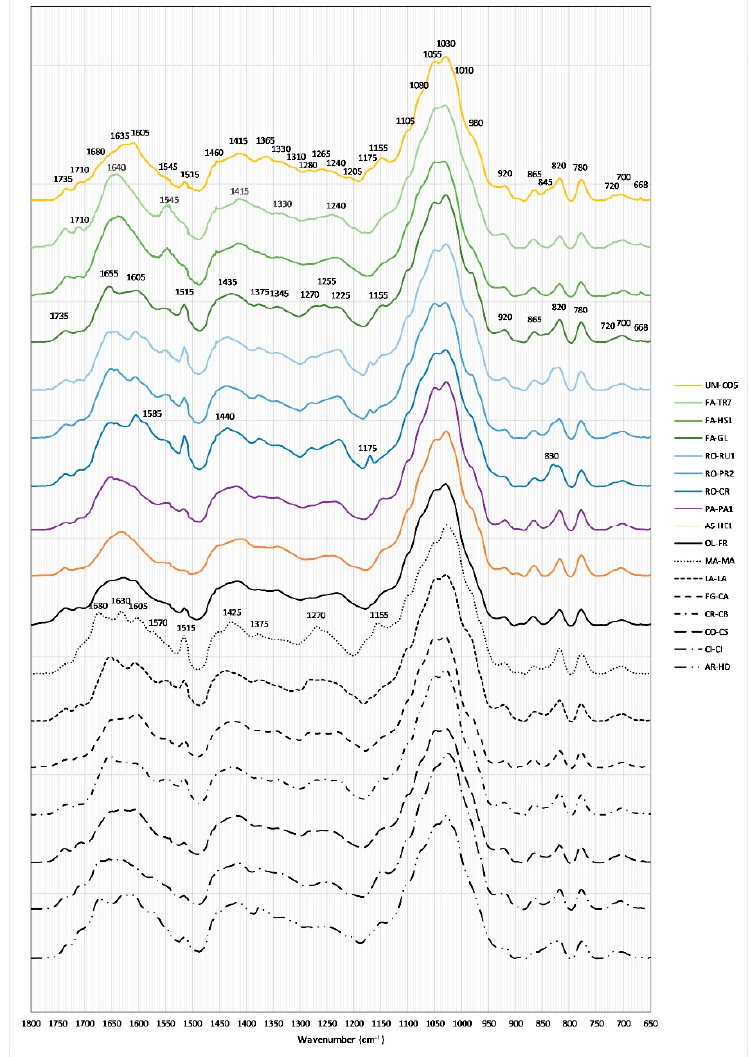
Figure 2. FTIR-ATR spectra of bee pollen samples. Only one sample representative of each genus is reported. Table 3. Meaningful FTIR-ATR peaks of pollen samples: peak position in terms of wavenumbers (cm − 1 ), vibrational mode and chemical assignment.